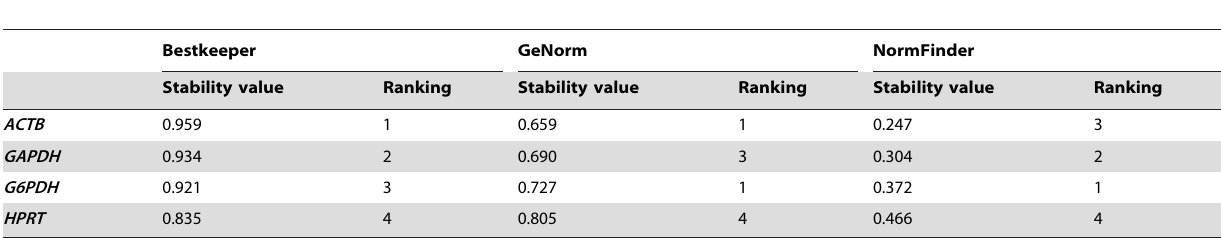
Table 3. Stability of four reference genes on liver from animals supplemented with 5 g of inulin kg -1 diet and controls, measured through three different software: Bestkeeper, GeNorm and NormFinder.